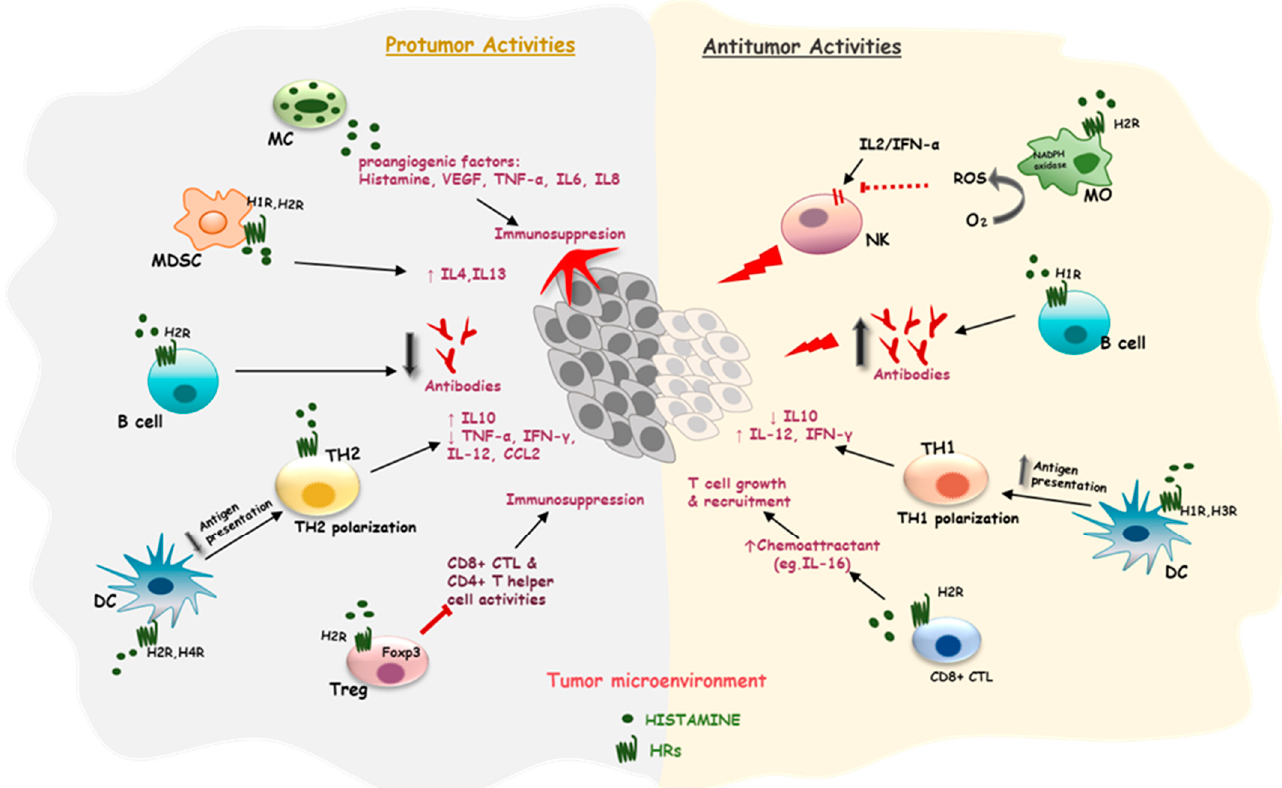
Figure 2. Bivalent roles of histamine and histamine receptor subtypes in the tumor microenvironment (TME). Histamine may exert either pro- or antitumor activities during tumor progression. Histamine also establishes cross-talk with other tumor-infiltrating immune cells in the TME by interacting with its corresponding receptors expressed on the cell surface, thus altering the final tumor outcomes. Representative actions of histamine in these cells are depicted in the figure. MC: mast cell; MDSC: myeloid-derived suppressor cell, TH1: CD4+ T helper 1 cell; TH2: CD4+ T helper 2 cell; CD8+ CTL: cytotoxic T lymphocyte; NK: natural killer; MO: macrophage; DC: dendritic cell; HRs: histamine receptors.